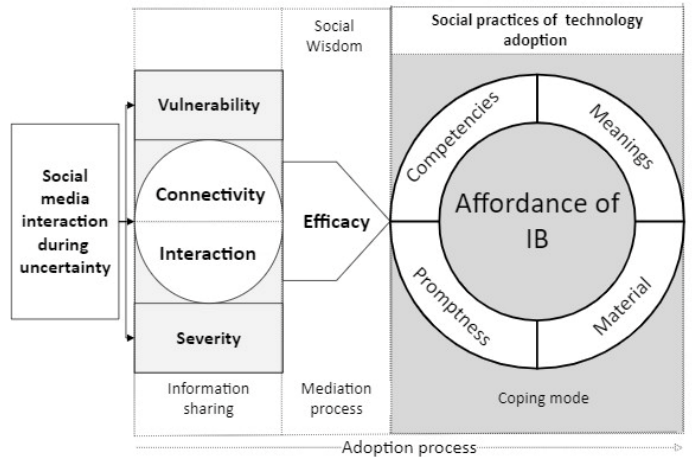
Fig. 2. Analysis of social media interaction and adoption